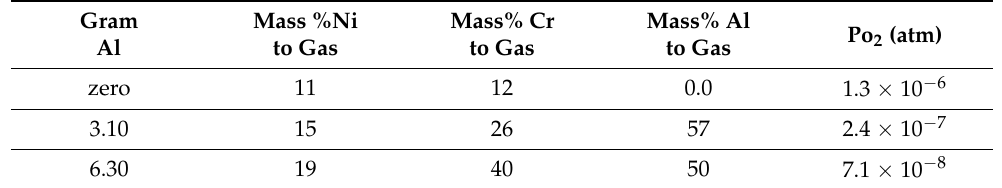
Table 8. Expected metal loss to gas according to gas-slag-metal powder equilibrium at 2500 ◦ C calculated in FactSage 7.3 thermochemical software (Equilib module) [30].